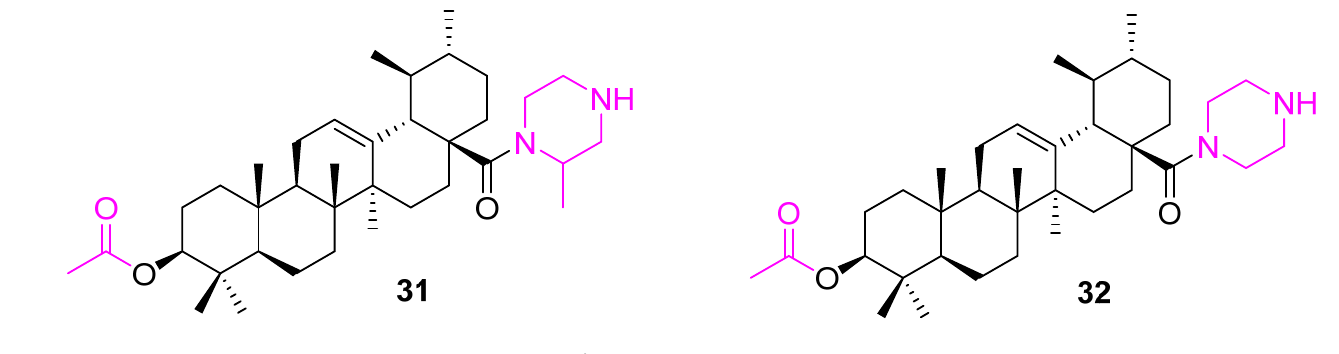
Figure 20. Structure of 31 , 32 .